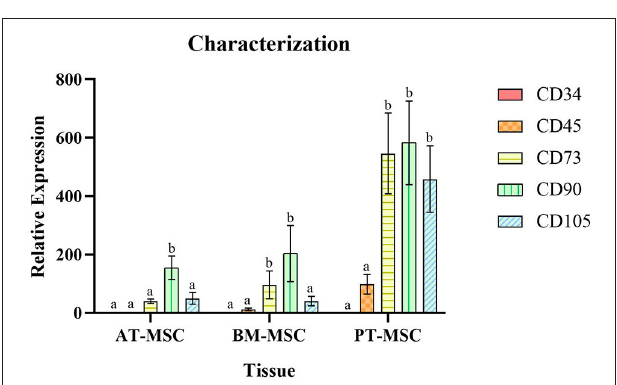
FIGURE 2 | Average relative expression ± SEM of hematopoietic (CD34 and CD45) and mesenchymal markers (CD73, CD90, and CD105) in bovine fetal adipose tissue (AT-MSC), bone marrow (BM-MSC), and placenta (PT-MSC) mesenchymal stem cells. (a, b) Different letters represent significant statistical differences ( P < 0.05) with respect to CD34 within the same tissue.